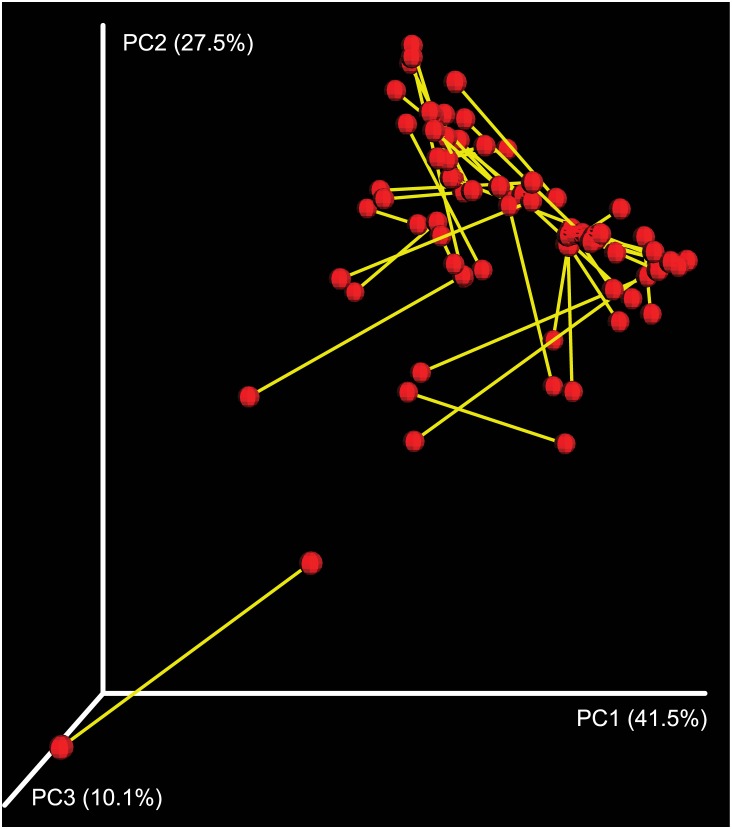
Procrustes analysis of 40 nasopharyngeal sample pairs collected 5.5 to 6.5 months apart.Sample pairs (red dots) collected from the same patient are connected by a yellow bar. The length of the bar is proportional to the dissimilarity between sample pairs.